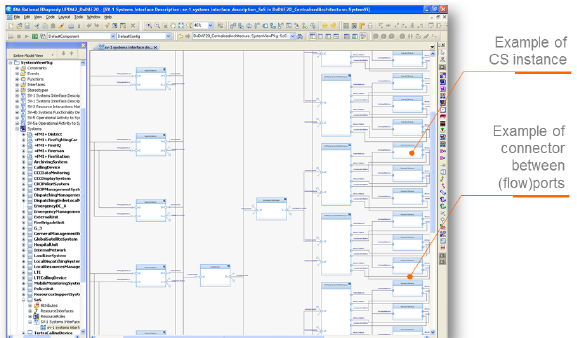
Figure 10. SoS architecture in